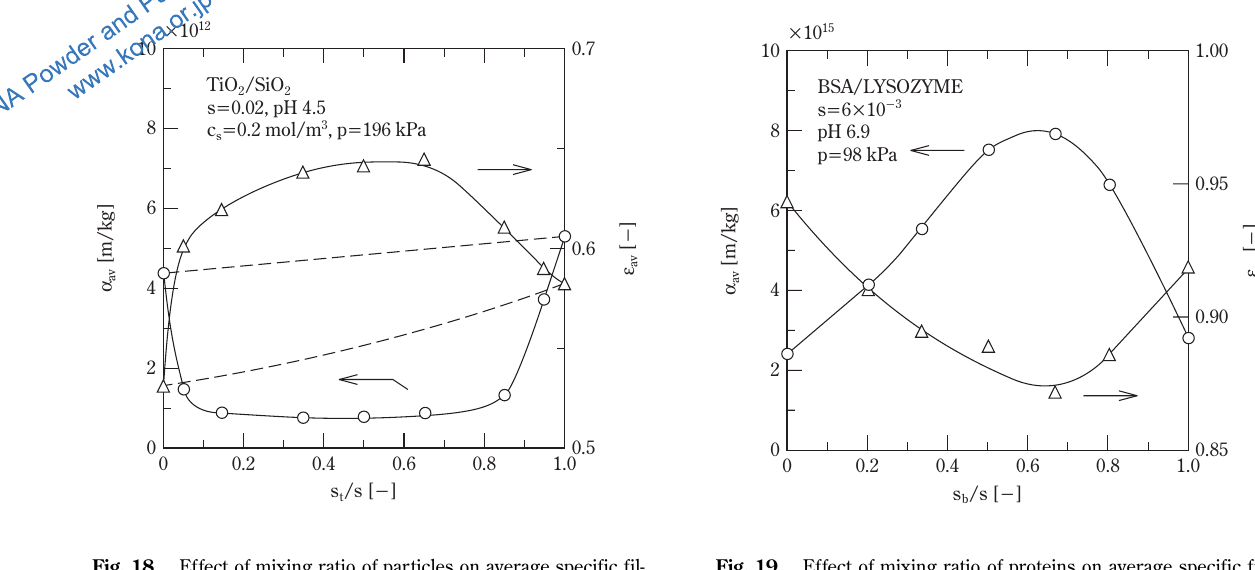
Fig. 18 Effect of mixing ratio of particles on average specific fil- tration resistance and average porosity in microfiltration of binary particulate mixtures at pH 4.5.